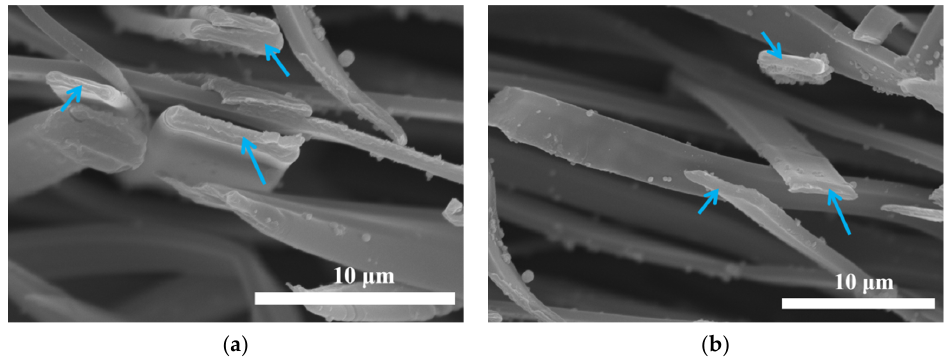
Figure 4. The cross sections SEM images of ( a ) GZ1’, ( b ) GZ2’.